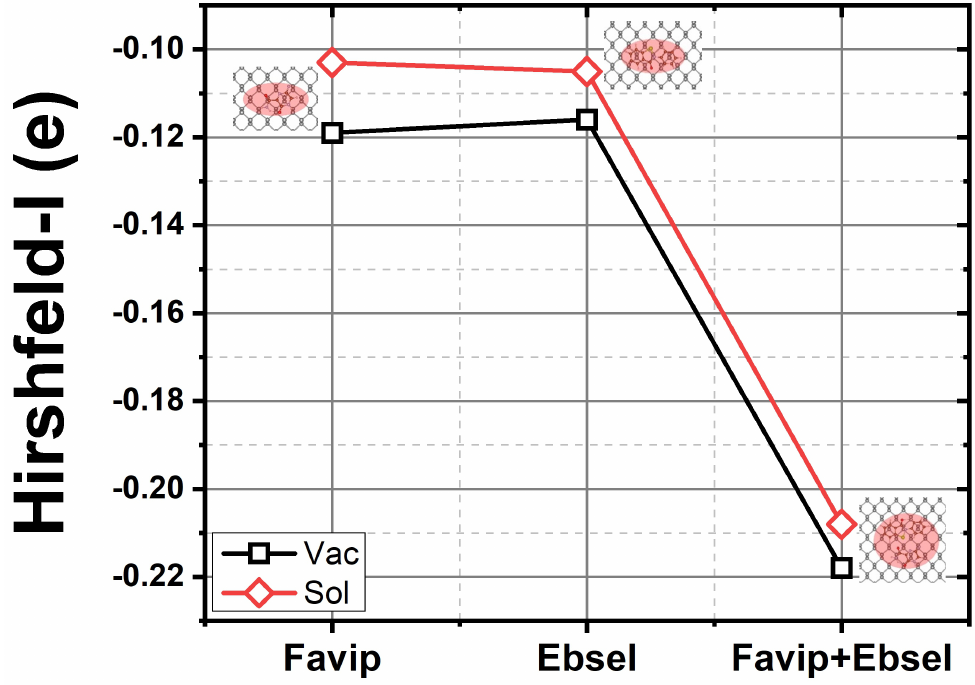
Figure 5. The calculated Hirshfeld–I charge transfer from BP sheet to respective favipiravir, ebselen, and favipiravir+ebselen hybrid molecules in a vacuum (black) and with solvent